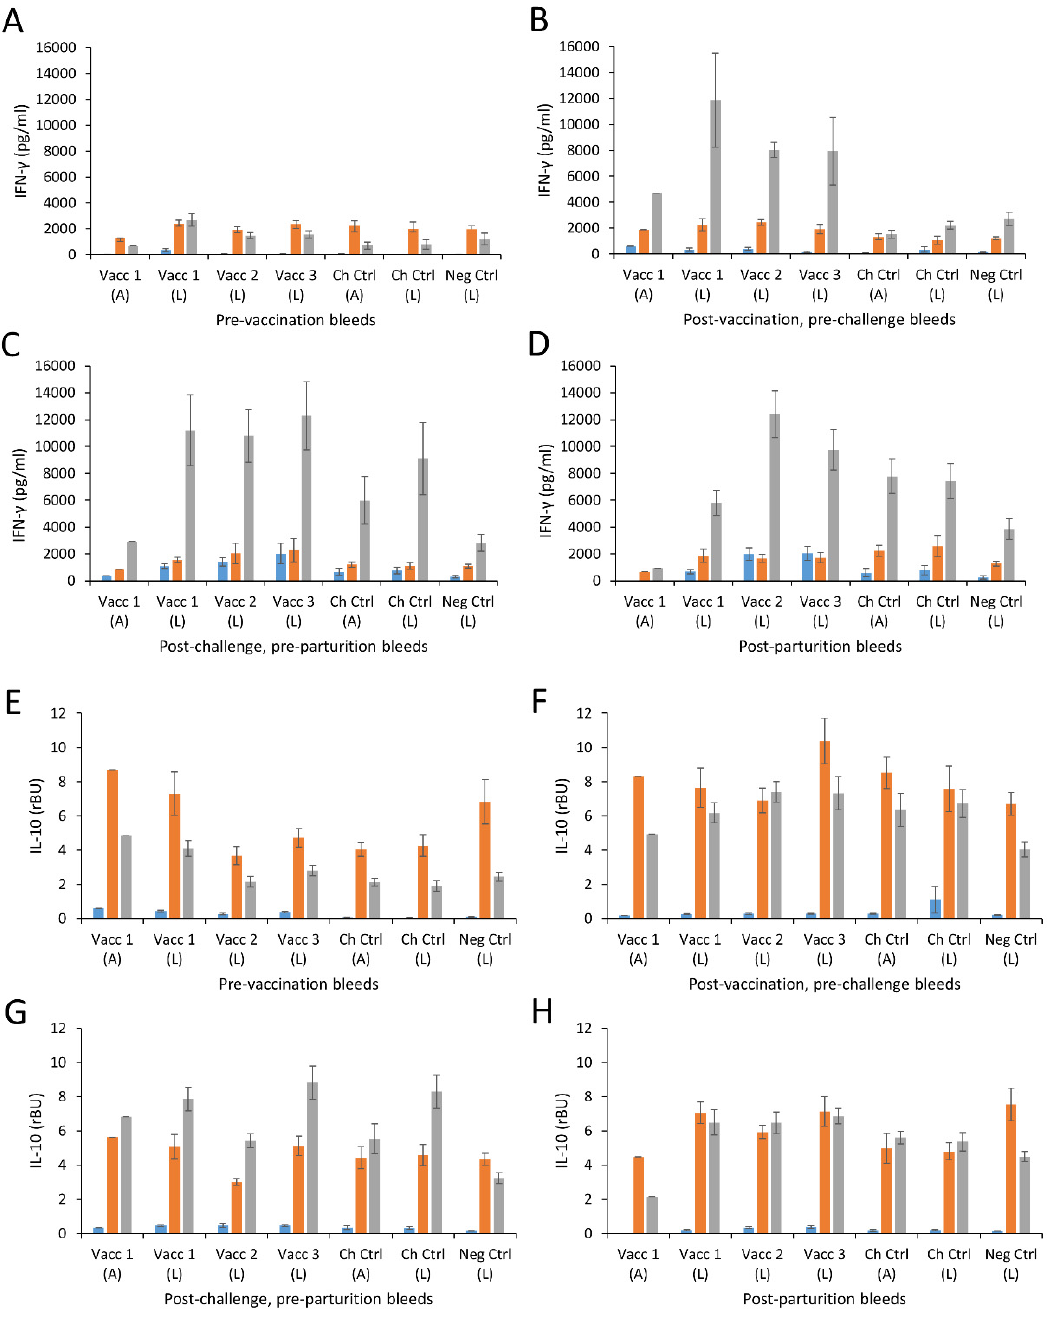
Figure 3. Interferon- γ and IL-10 responses following vaccination and challenge with Chlamydia abortus . Peripheral blood mononuclear cells (PBMC) from the animals in the commercial (Vaccine 1) and experimental (Vaccines 2 and 3) vaccine groups were purified from whole blood (as described in Section 2.12 “Cellular Analysis”) collected pre-vaccination ( A , E ), post-vaccination/pre-challenge ( B , F ), post-challenge/pre-parturition ( C , G ) and post-parturition ( D , H ) (also see Figure 1). PBMC were set up in lymphocyte stimulation assays in vitro using medium only as an unstimulated cell control (blue bars), the mitogen Concanavalin A (ConA) as a positive control (orange bars) and UV-inactivated C. abortus EB antigen (grey bars) for measuring chlamydial antigen-specific stimulation. Antigen-specific recall responses were assessed by analysis of the culture supernatants for cytokines IFN- γ ( A – D ) and IL-10 ( E – H ). Data for lambed (L) and aborted (A) ewes are presented separately. Data points represent the mean values for each cellular bleed and error bars represent the stand- ard error of that mean (SEM).